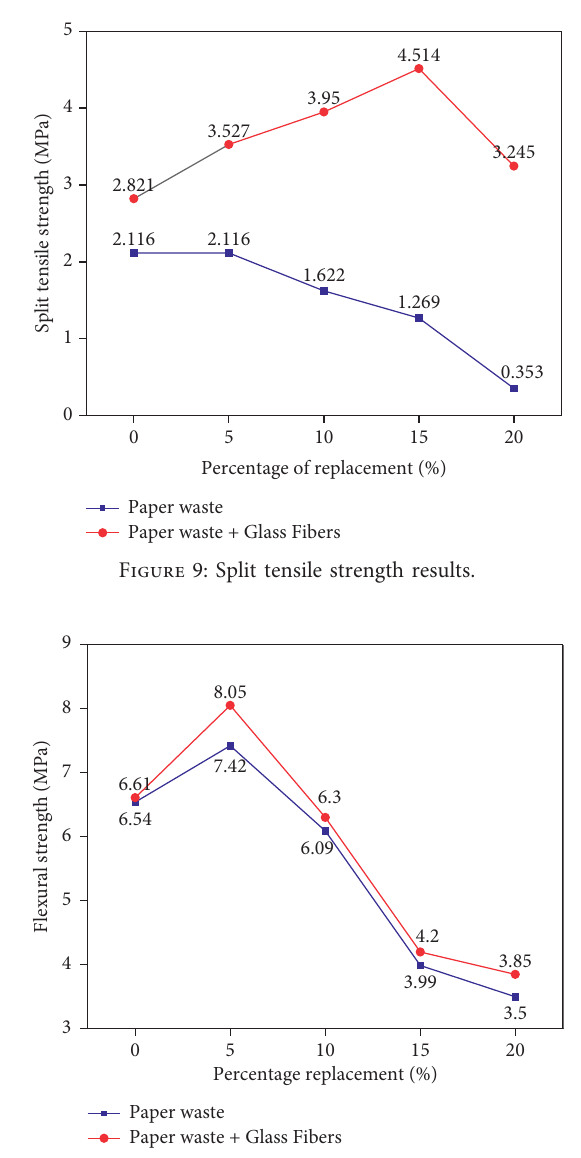
Figure 10: Flexural strength